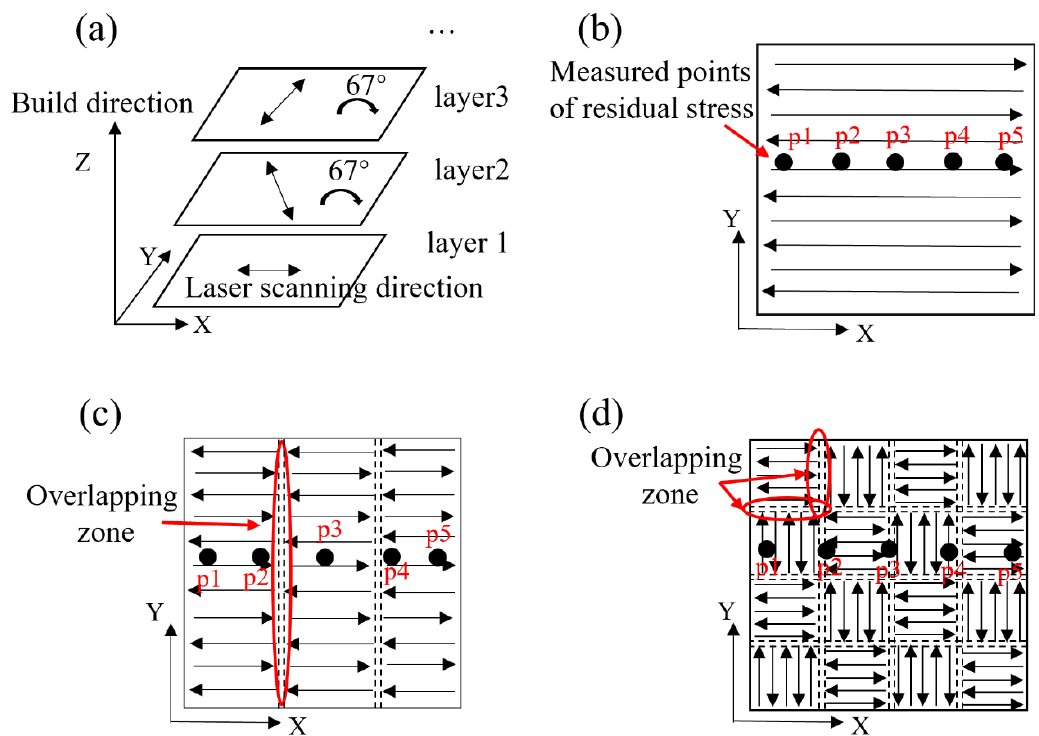
Figure 1. Schematic of the scanning strategies for selective laser melting (SLM) and residual stress measured points (p1, p2, p3, p4, and p5); ( a ) laser scanning route; ( b ) snake scanning; ( c ) stripe partition scanning; and ( d ) chessboard partition scanning.